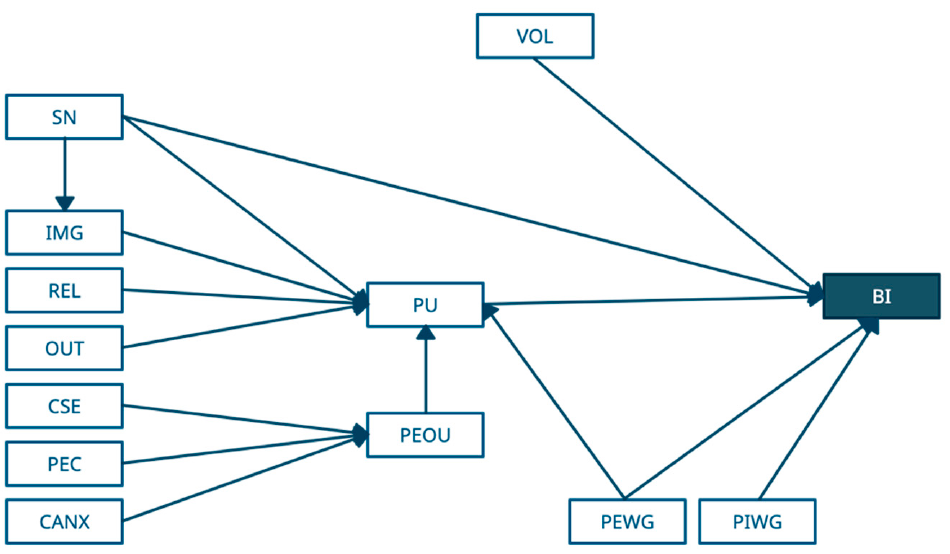
Figure 2. Illustration of our validated model.